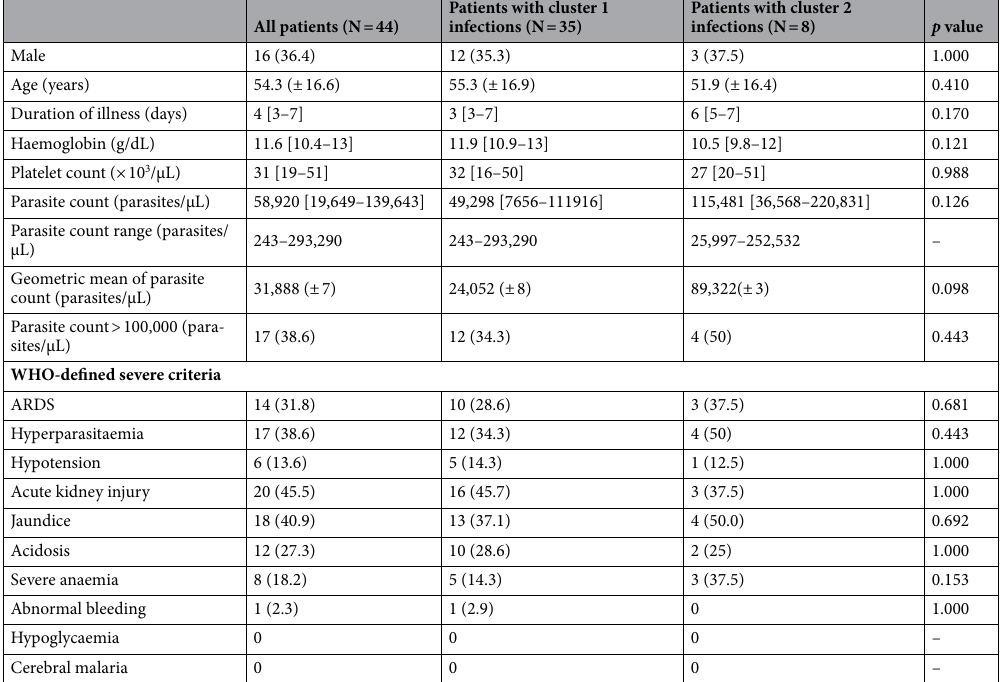
Table 4. Demographics and characteristics among severe knowlesi malaria infections. Data are presented as no. (%), mean (± SD) and median [IQR] unless otherwise stated. One severe case had mixed infection with cluster 1 and cluster 2. p value is between cluster 1 and cluster 2. Hyperparasitaemia is defined as > 100,000 parasites/μL; severe anaemia—haemoglobin level < 7 g/dL; hypotension—systolic blood pressure < 80 mmHg;